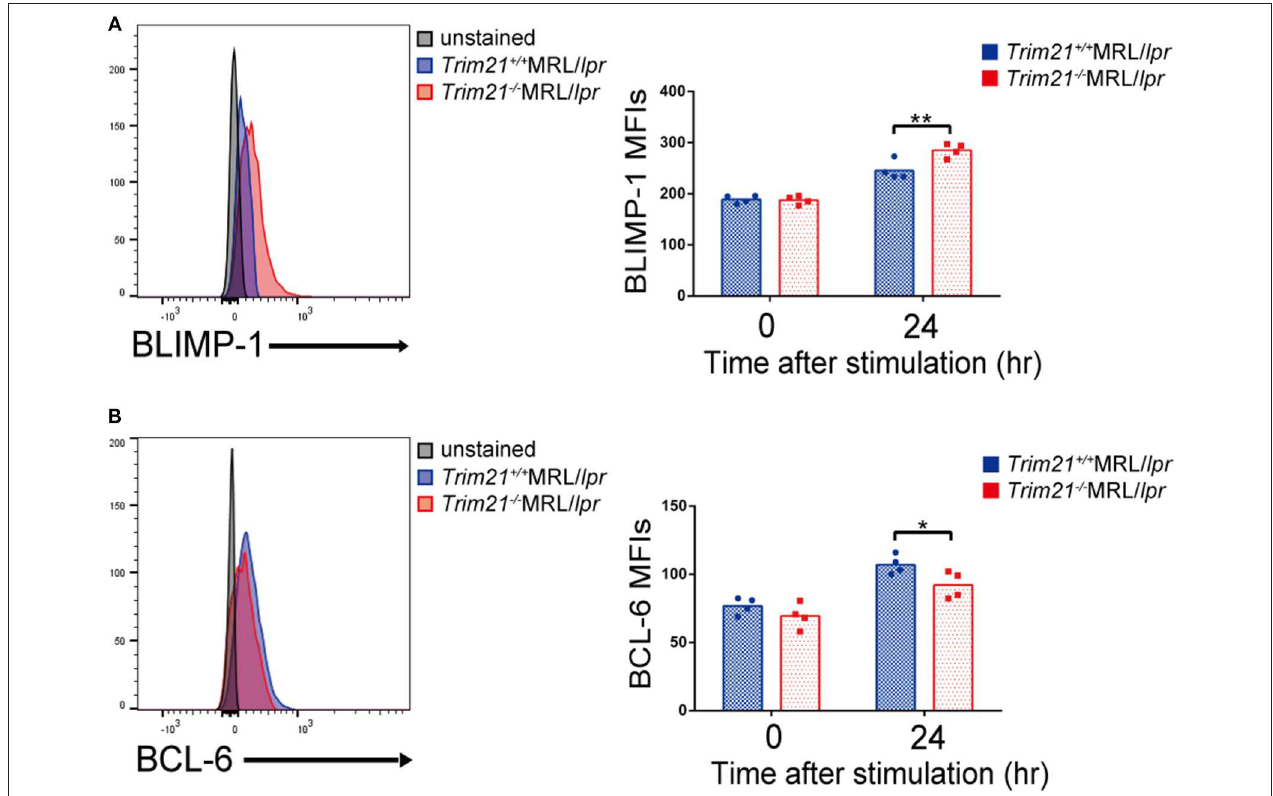
FIGURE 9 | TRIM21 deficiency promotes BLIMP-1 overexpression and suppresses BCL-6 expression. (A,B) Flow cytometric analyses show that the intracellular expression level of BLIMP-1 is increased (A) and that of BCL-6 is decreased (B) by TRIM21 deficiency in resting B cells at 24h after stimulation with anti-IgM Ab and TLR3 ligand ( n = 4 in each group). Values are shown as means ± SEM. Statistically significance data (* p < 0.05 and ** p < 0.01) by Student’s t -test,